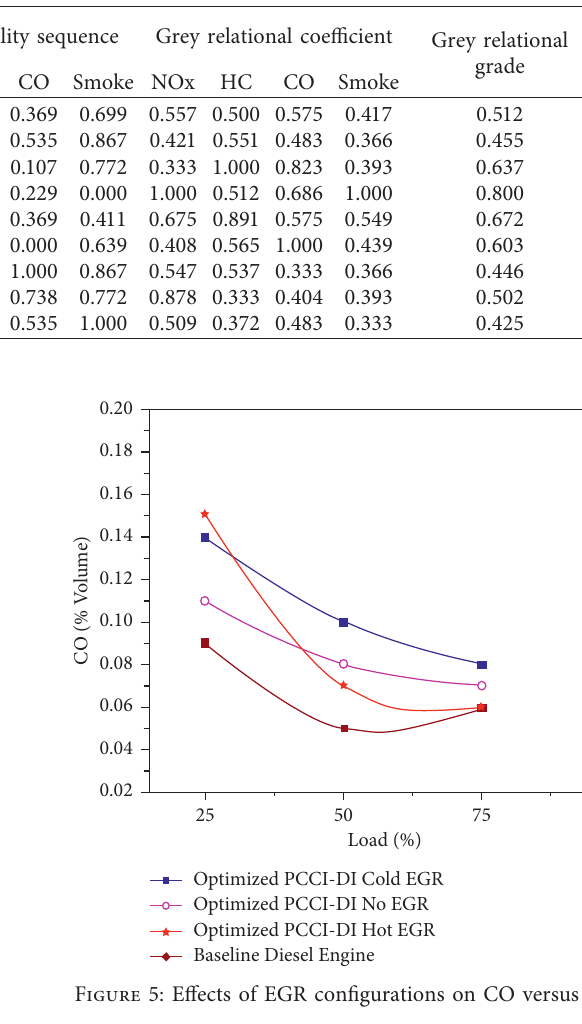
Table 4: Data preprocessing for response variables.